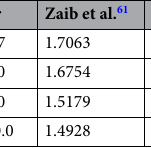
Table 2. Comparison of f ′′ ( 0 ) with published results of Zaib et al. 61 , when (cid:31) zero.